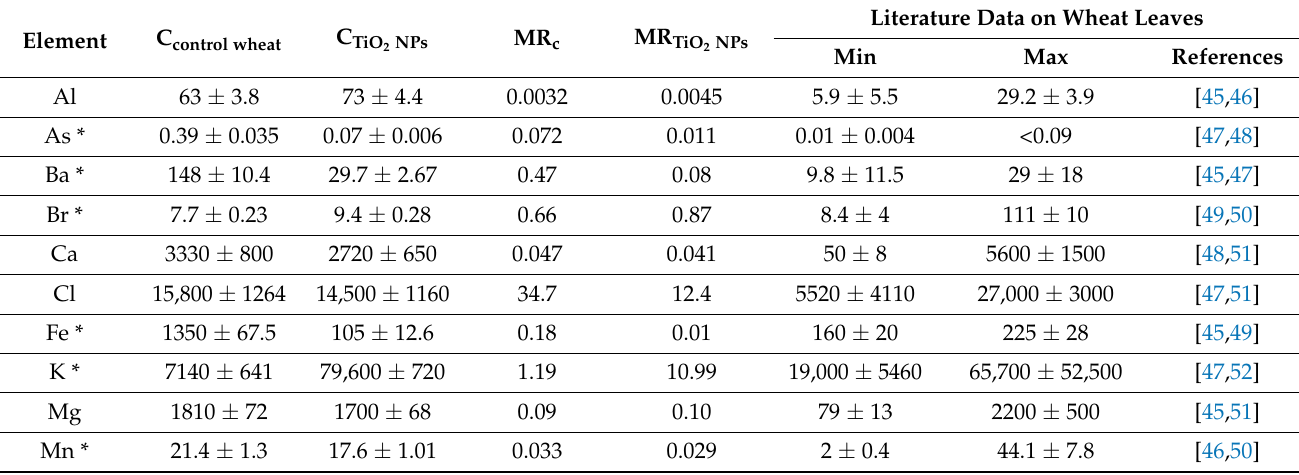
Table 2. Experimental and literature data for wheat content (mg/kg ± SD) and mobility ratio. Element C control